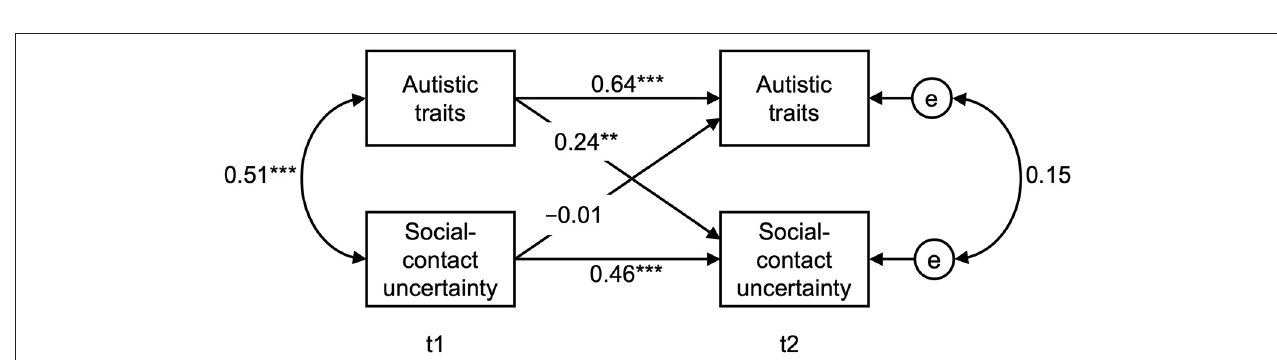
FIGURE 2 | Cross-lagged model to predict autistic traits and social-contact uncertainty over time. Correlations and standardized regression weights are shown. N = 118. * p < 0.05, ** p < 0.01, *** p < 0.001 (all two-tailed).